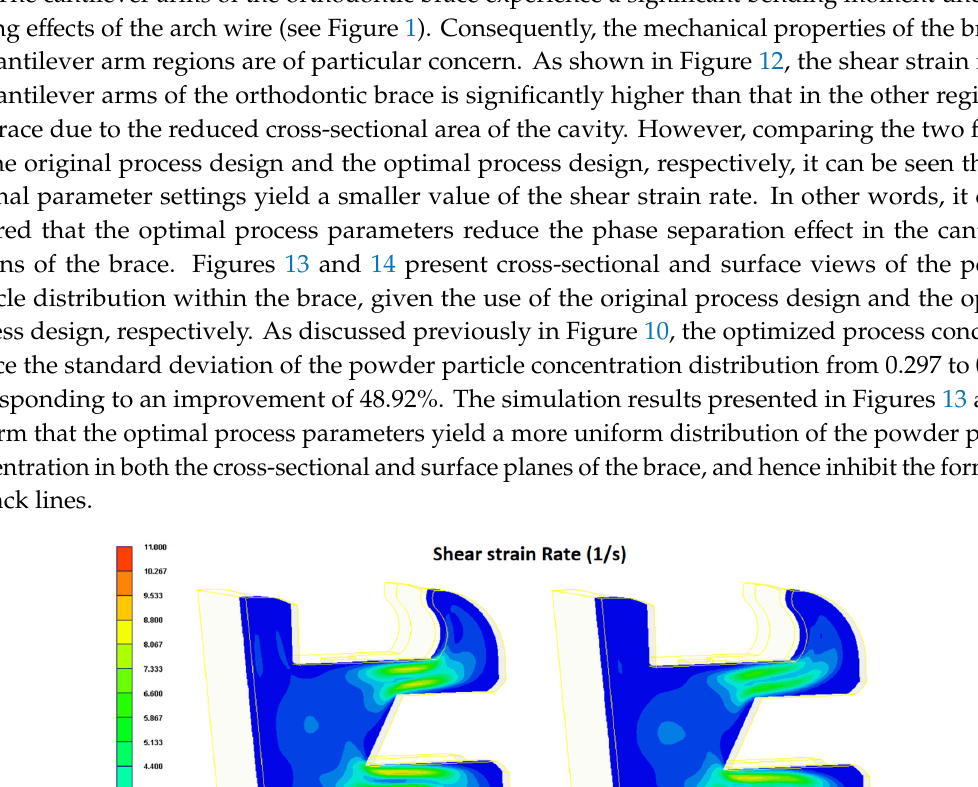
Figure 13. Comparison of metal powder concentration distributions in original process design and optimal process design.